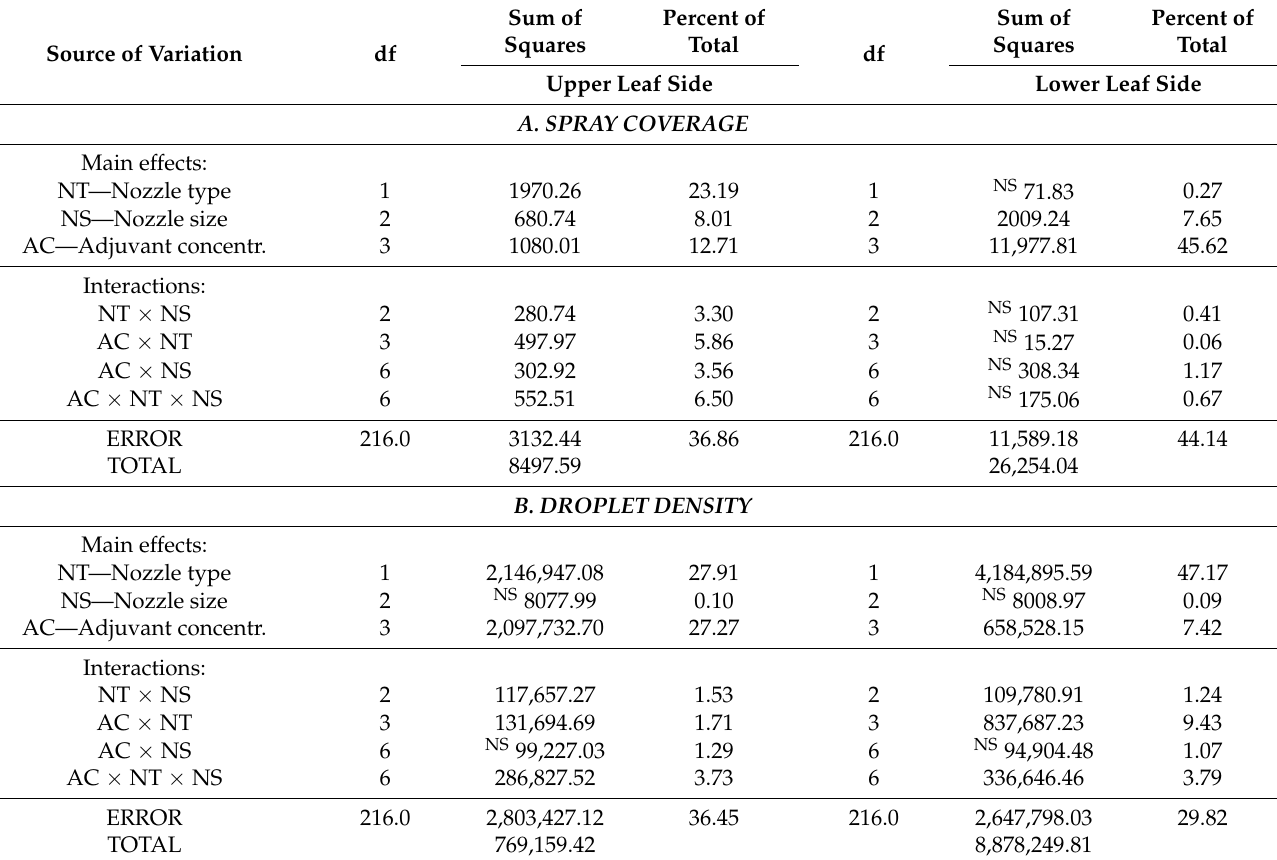
Table 5. The ANOVA summary table for data sets of spray coverage (A) and droplet density (B) on upper and lower surfaces of apple leaves obtained during the treatments with adjuvant Greemax. The denotation NS marks not significant effects or interactions at p <